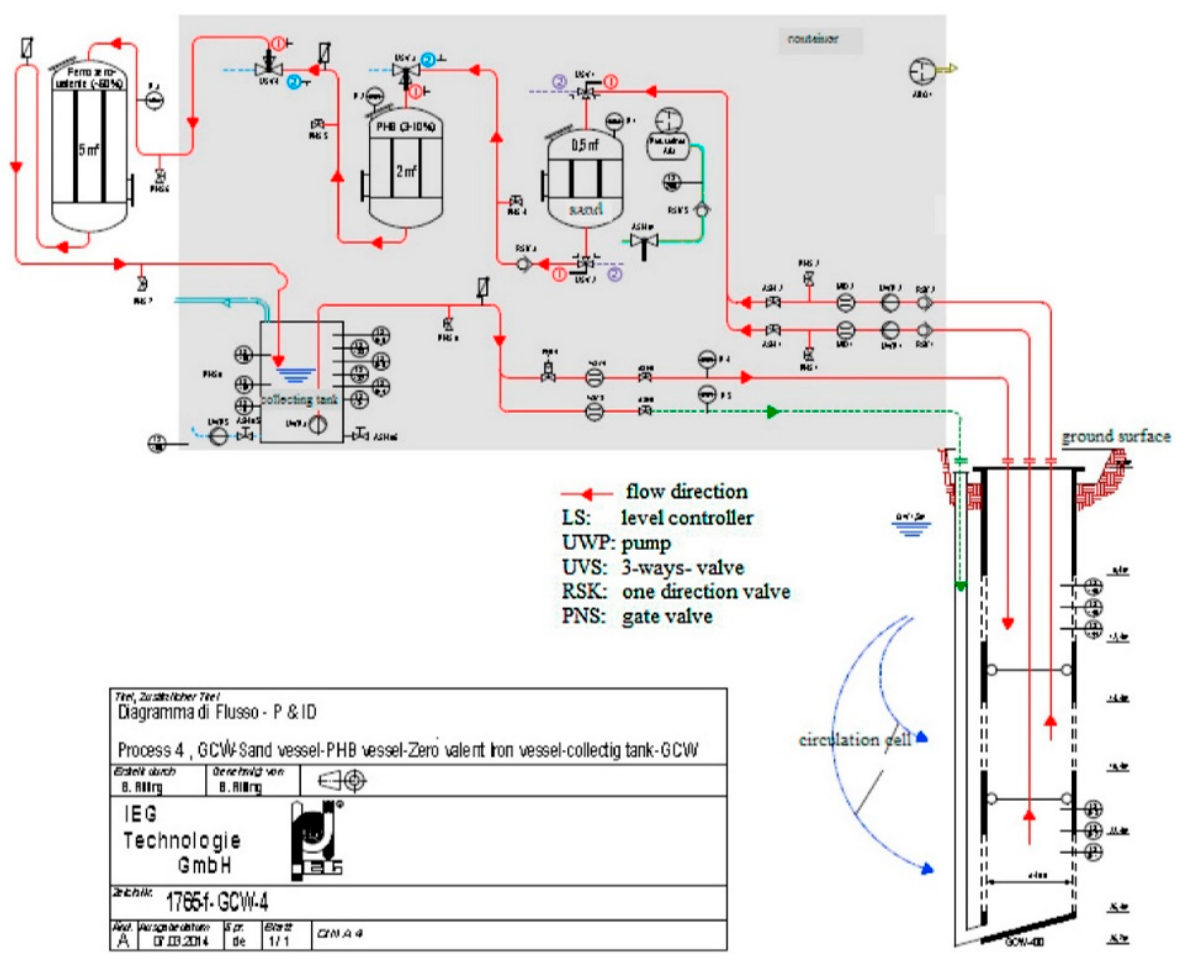
Figure 2. Piping and instrumentation diagram of the groundwater circulation well (GCW) and the polyhydroxybutyrate (PHB)-reactor and zero-valent iron (ZVI)/PHB-reactor in series. Figure from Pierro et al., 2017 [21]. Reproduced with the permission of